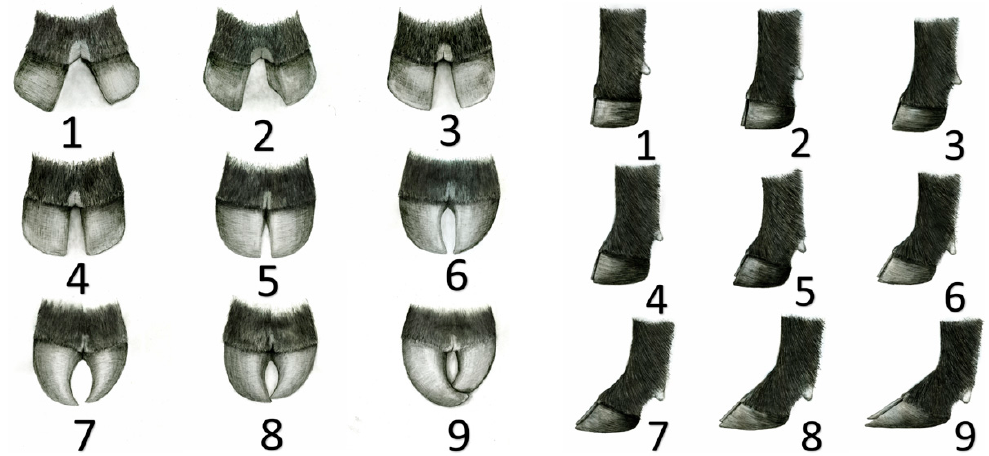
Figure 3. Foot score sketches courtesy of the American Angus Association characterizing claw scores ( left panels ) and pastern angles ( right panels